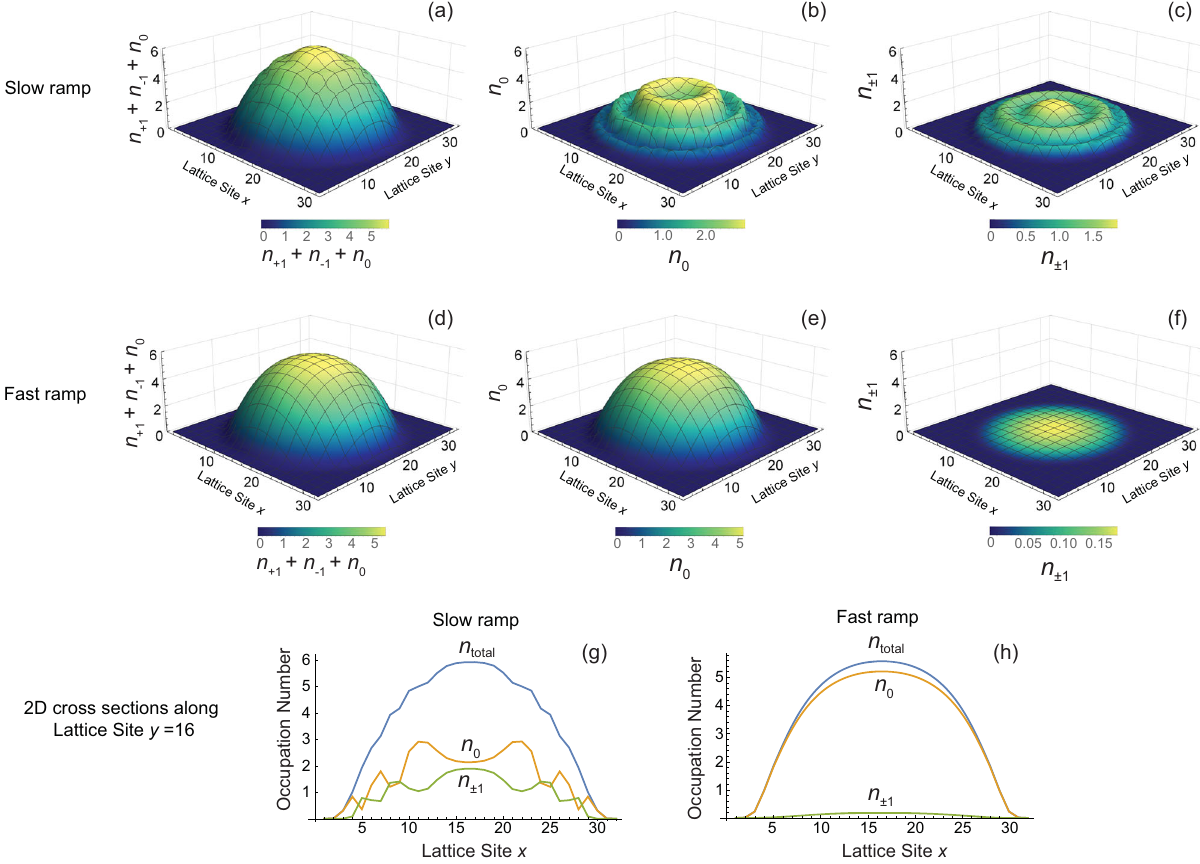
Fig. 1 Predicted density pro fi les after quenches across quantum phase transitions. a – c Predicted density pro fi les of all atoms, the m F = 0 atoms, and the m F = ± 1 atoms after a slow quench at the speed v = 5 E R ⋅ ms − 1 from a shallow lattice of the depth u L = 2 E R to a deep lattice at u L = 40 E R , respectively. ramp Here, E R is the recoil energy, m F is the magnetic quantum number, and the unit of v ramp is E R per millisecond ( E R ⋅ ms − 1 ). These density pro fi les are derived from our numerical simulations for 2D lattice-trapped sodium spinor gases of n peak = 6 at q / h = 42 Hz using the Bose – Hubbard model and the Gutzwiller approximation (see “ Methods ” ). Here, n peak is the peak occupation number per lattice site, q is the quadratic Zeeman energy, and h is the Planck constant. d – f Similar to panels ( a – c ) but after a fast lattice quench with v ramp = 50 E R ⋅ ms − 1 . The horizontal axes indicate individual lattice sites along the spatial x - axis and y -axis, respectively. The color scale and vertical axis indicate n , the occupation number per lattice site. g , h 2D cross sections of panels ( a – c ) and panels ( d – f ) at the 16th lattice site along the y -axis,